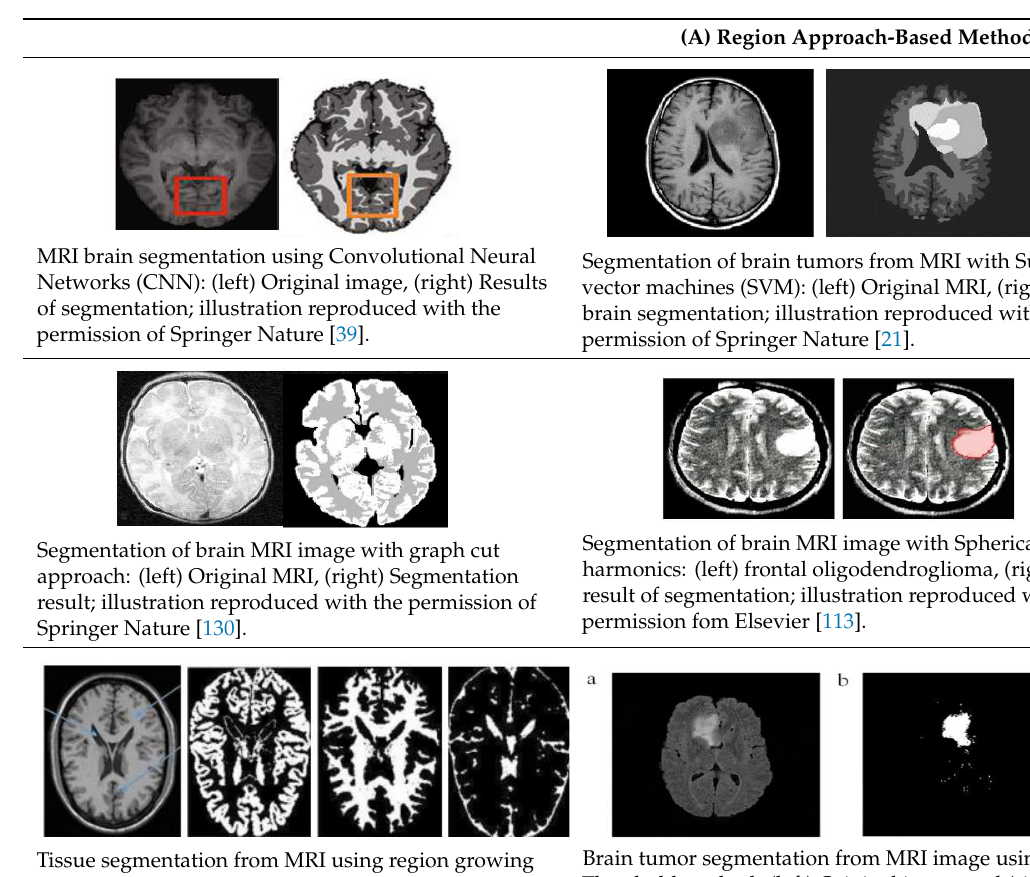
method: (left to right) Original image, grey matter, white matter and CSF; illustration reproduced with the permission of Springer Nature [132].